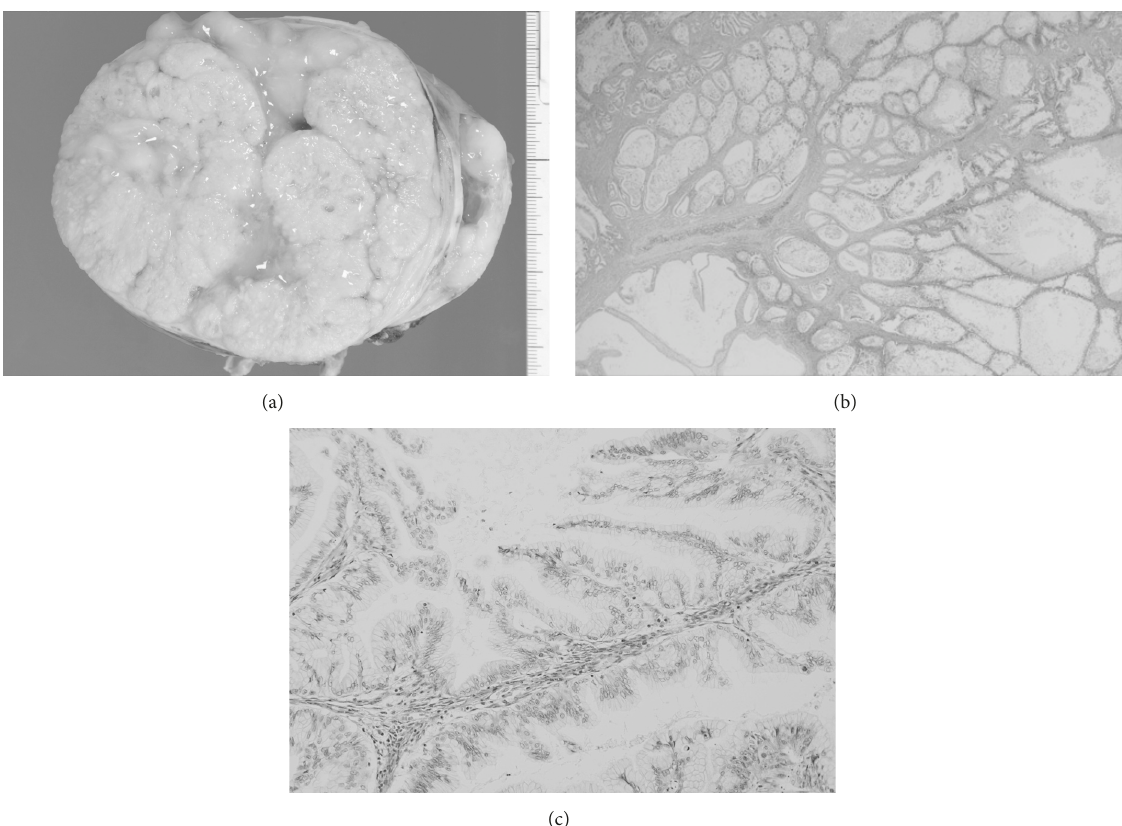
Figure 3: (a) A surgical specimen from right adnexectomy of a 12 × 9 × 7 cm mass revealed a yellowish-white cut surface, a smooth internal surface, and an almost solid component. (b) Microscopy examination revealed multiple small or microcystic spaces that contained mucinous fluid or hemorrhage and ovarian stromal intervening fibrous tissues and multiple vascular spaces. (c) Microscopic examination of the papillary-structured architecture revealed mucus-producing tumor cells with moderate